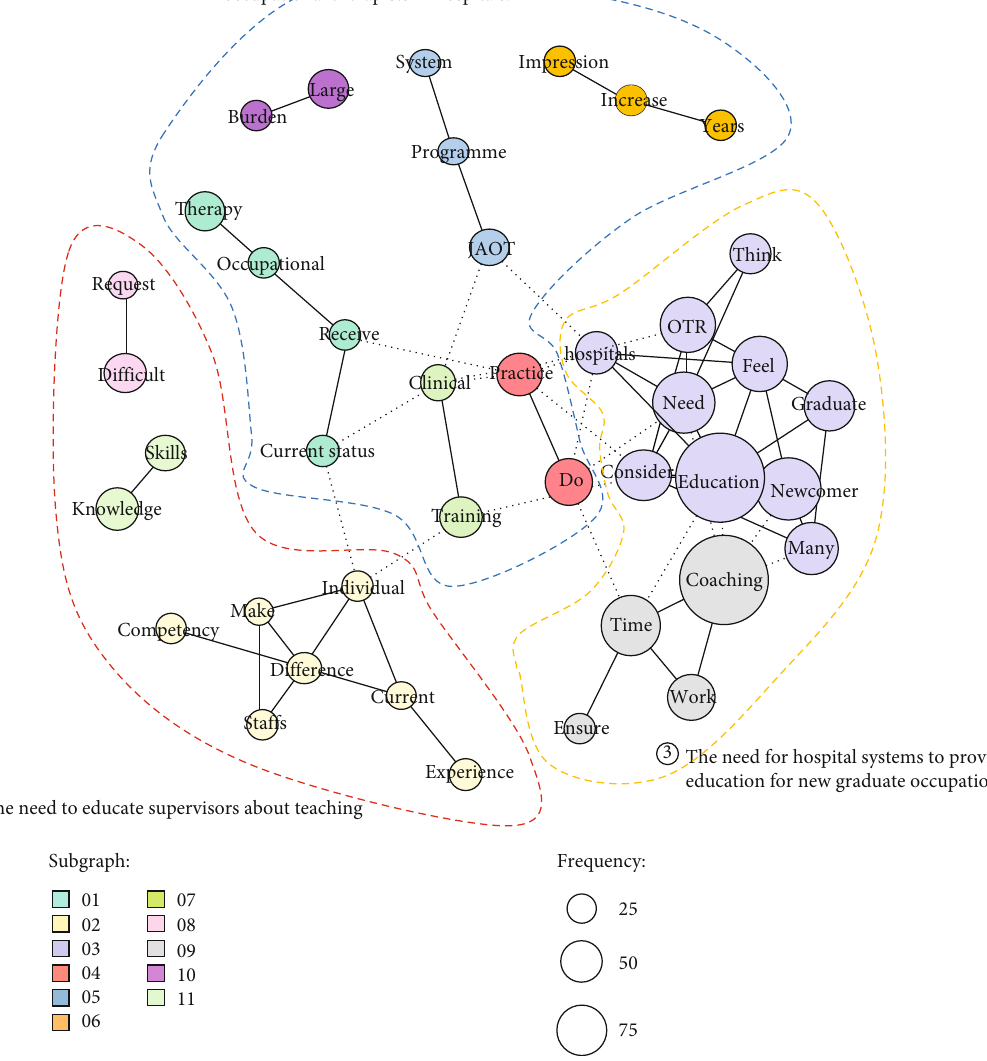
Figure 2: Cooccurring networks of issues in the education of new graduate occupational therapists. ( n = 144